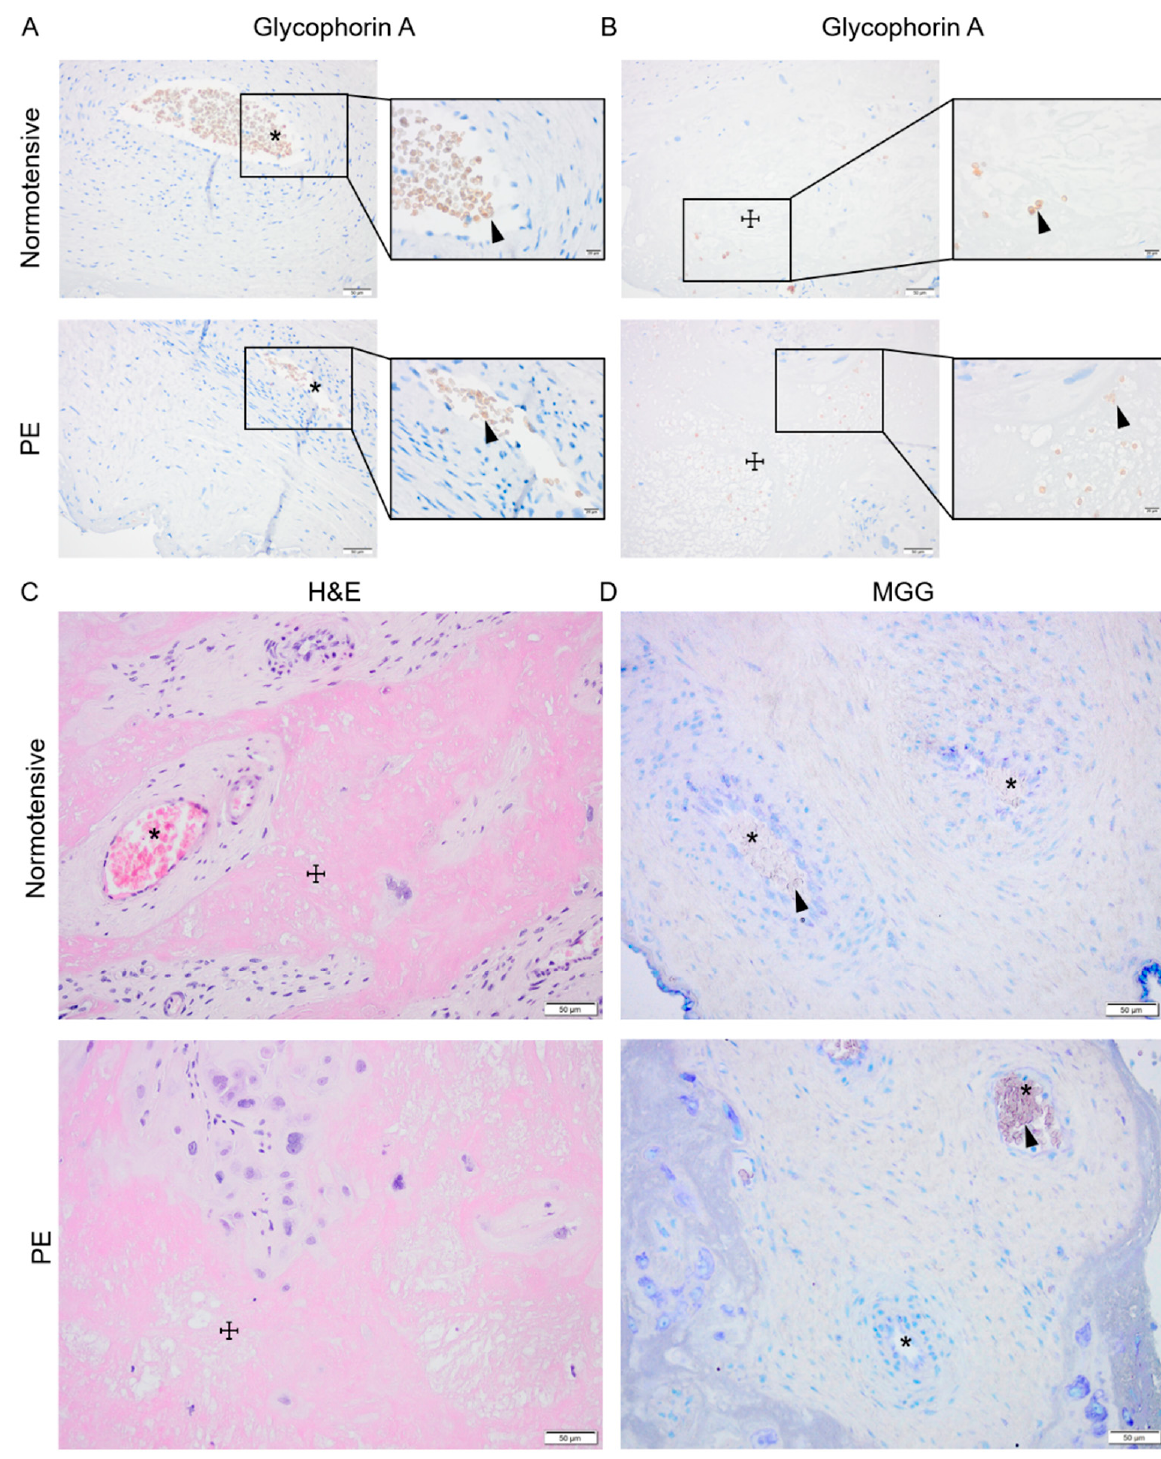
Figure 2. Investigating placental erythropoiesis and distribution of the erythroid cells in the placenta. Immunostaining for glycophorin-A (brown) indicating erythrocytes (arrowhead) in placental vessels (*) and areas with fibrosis ( ☩ ) in normotensive and PE placentas ( A , B ), the nuclei (dark purple) were stained by hematoxylin. Hematoxylin and eosin (H&E) staining of normotensive and PE placentas indicating the fibrinoid areas ( C ). May–Grünwald–Giemsa (MGG) staining in normotensive and PE placentas ( D ). Scale bar is 50 µm in all images except for inserted higher magnifications in ( A , B ) where it is 20 µm.